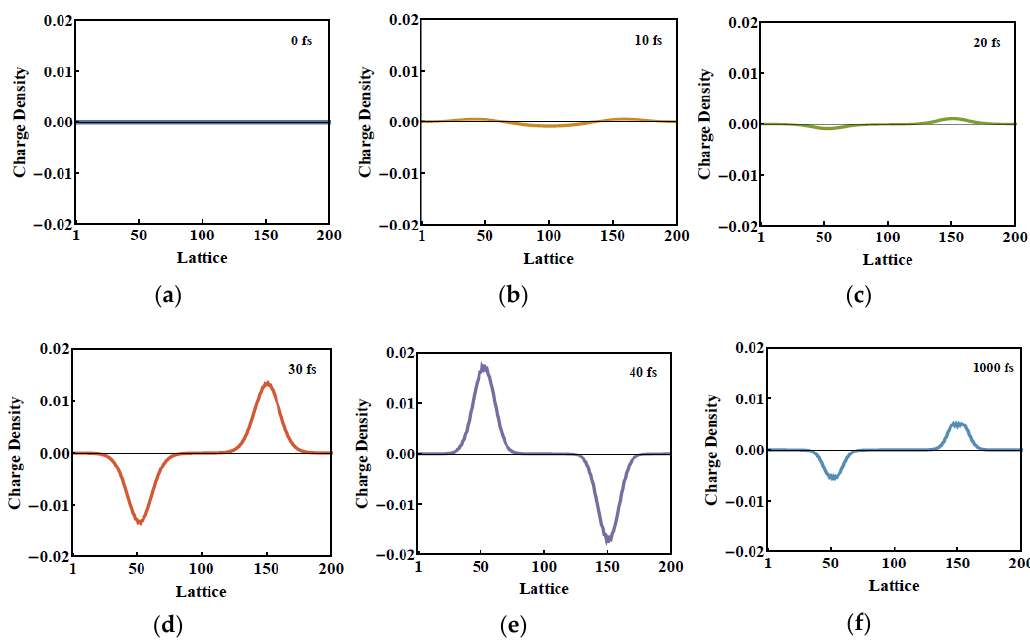
Figure 6. ( a )–( f ) Evolution of the charge density distribution along the poly(p-phenylene vinylene) (PPV) polymer chain by an external laser of 70 µJ/cm 2 at 0 fs, 10 fs, 20 fs, 30 fs, 40 fs, and 1 ps. After ASE appears under photoexcitation by an optical field of intensity 70 µJ/cm 2 , the